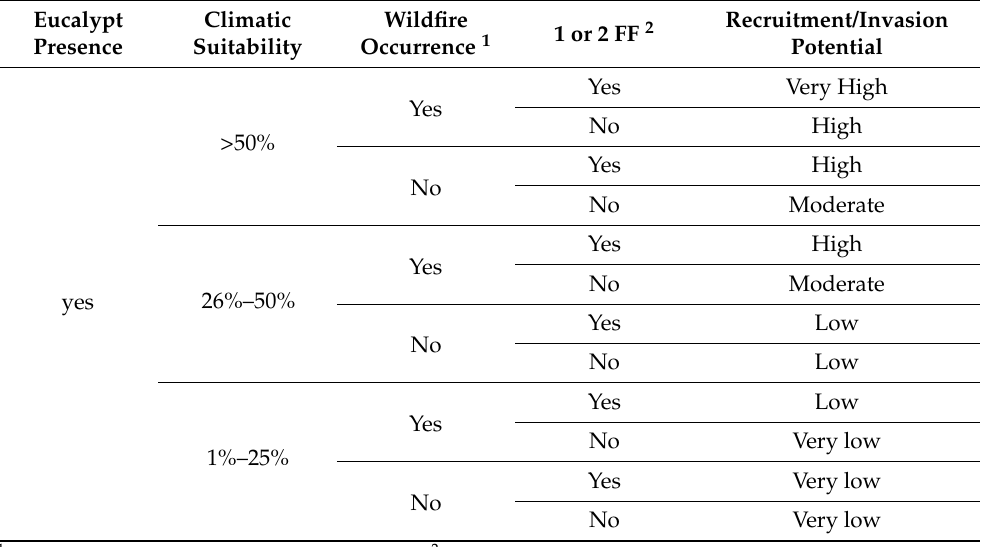
Table 2. Combination of factors used for the classification of recruitment potential and invasion potential of eucalypt stands and adjacent areas inside the Natura 2000